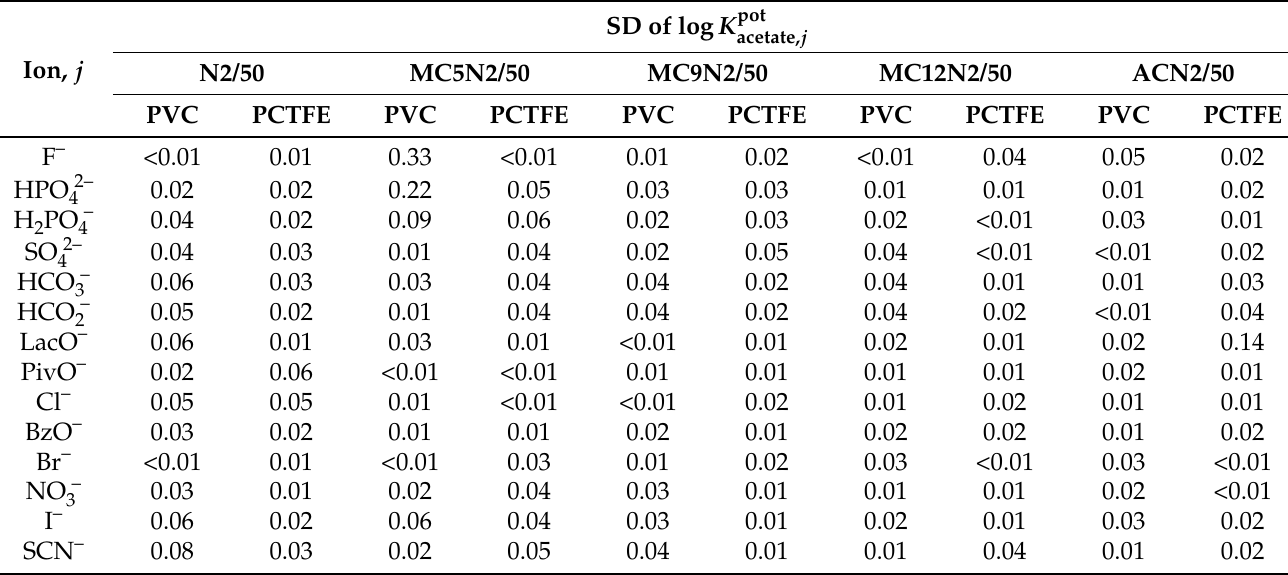
Table A10. Standard deviations for the average selectivity coefficients in Table A9. The number of measurements and the number of sensors were n = 1 and k = 2, respectively. See Table 1 for membrane